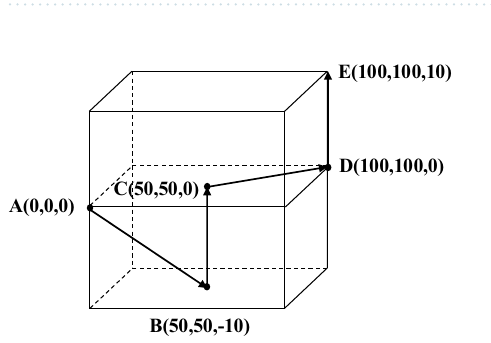
Figure 18. 3D space displacement test platform (The figure was generated by Microsoft Visio Professional 2016 (https:// www. micro soft. com/ zh- CN/ downl oad/ detai ls. aspx? id= 51188)).